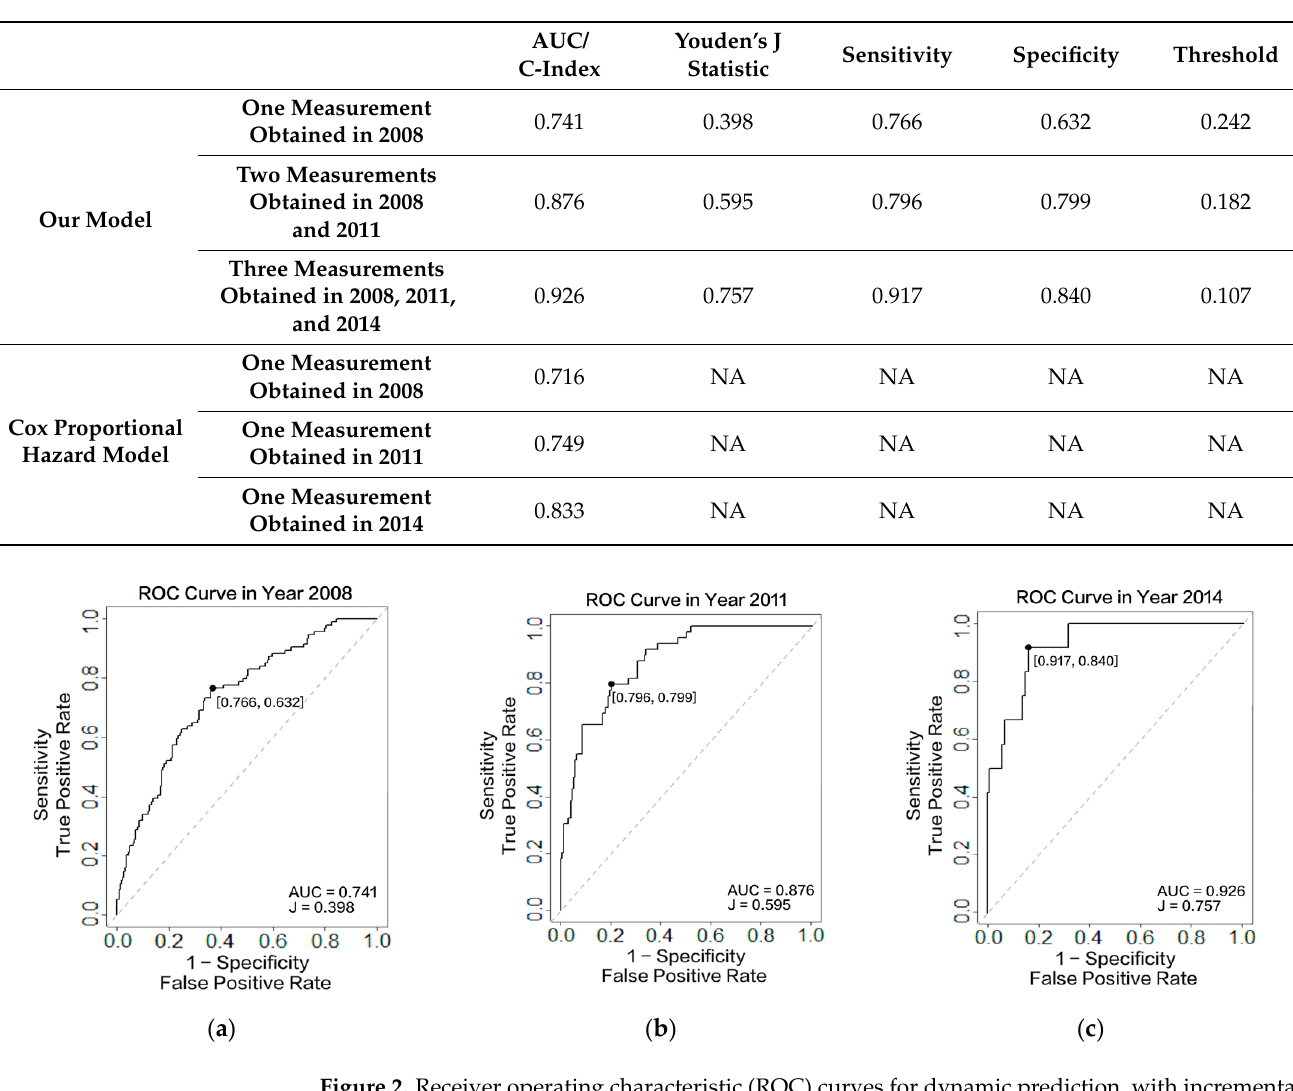
Table 3. Prediction accuracy of the proposed model with different numbers of measurements.